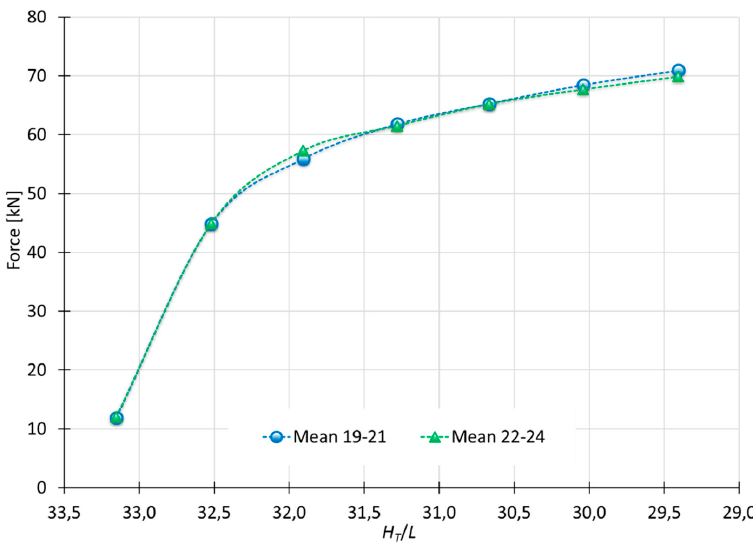
Figure 15. Indentation forces obtained from test with different speeds.